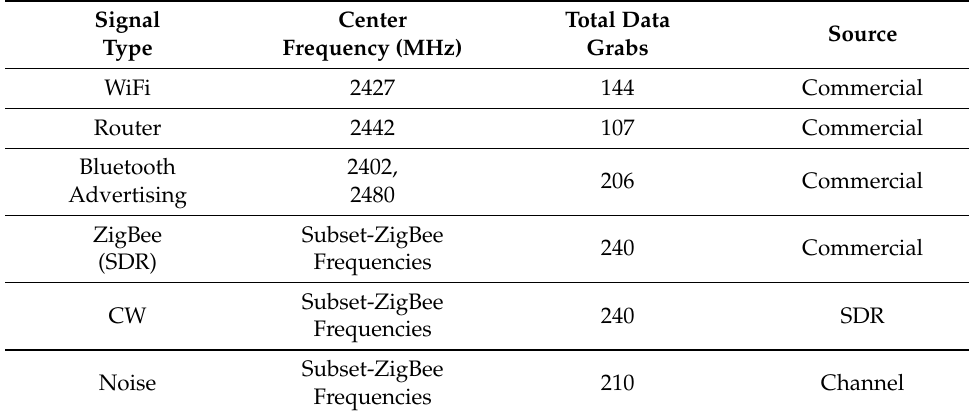
Table 2. Summary of Collected Data—Unseen Test